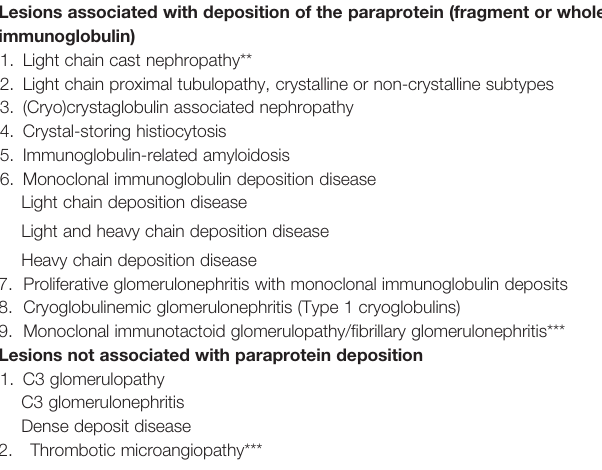
TABLE 1 | Monoclonal Gammopathies of Renal Signi fi cance (MGRS)*. Lesions associated with deposition of the paraprotein (fragment or whole immunoglobulin)